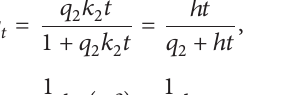
that the binding of GA on EDA-AC may be dominated by physical adsorption